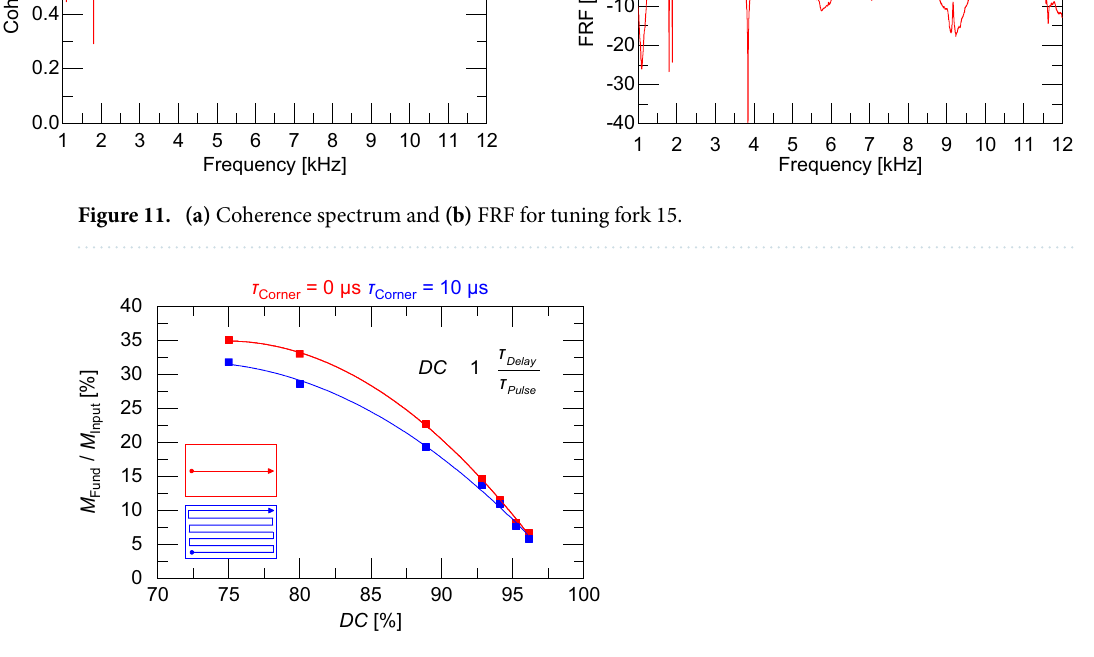
Figure 12. Percentage of energy located in fundamental frequency for various duty cycles and both straight (red) and raster (blue)